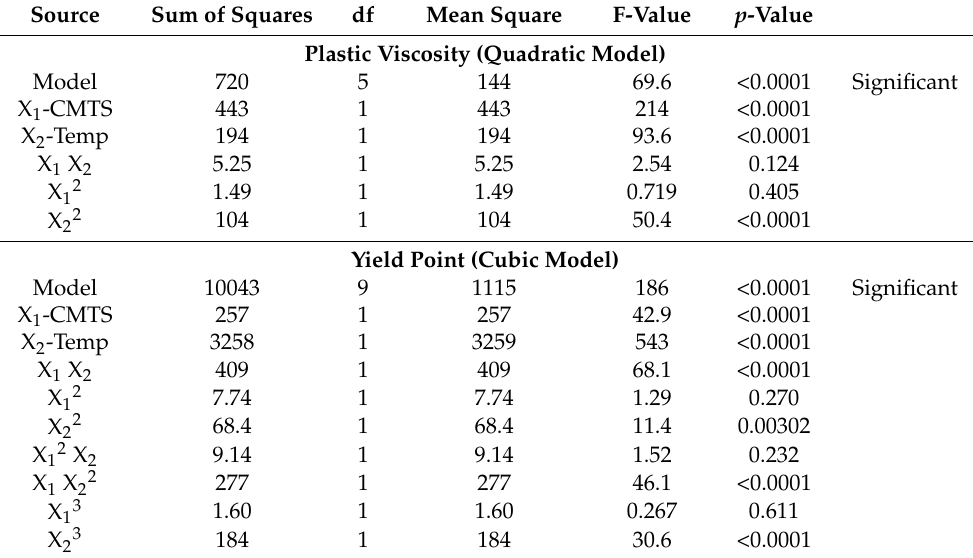
Table 5. Summary of ANOVA for model’s